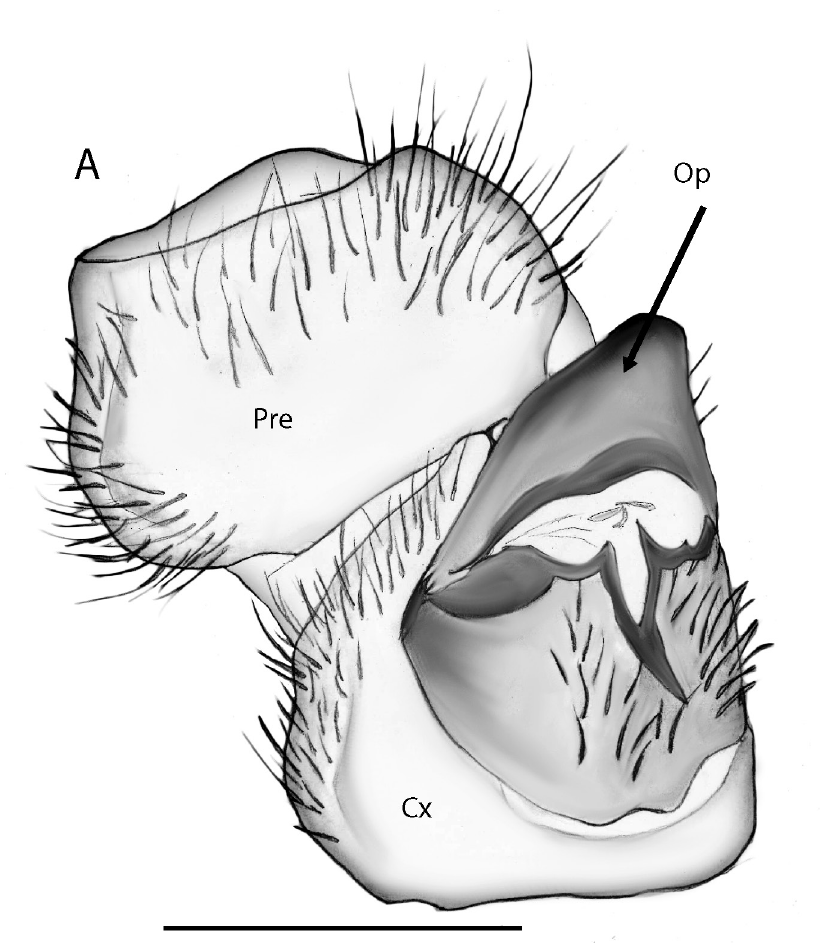
Fig. 11. Zephronia viridisoma Rosenmejer & Wesener sp. nov., paratype, ♀ (NHM D621696), drawings. A . Second right coxa and prefemur with vulva, posterior view. Abbreviations: Cx = coxa; Op = operculum; Pre = prefemur. Scale bar = 1